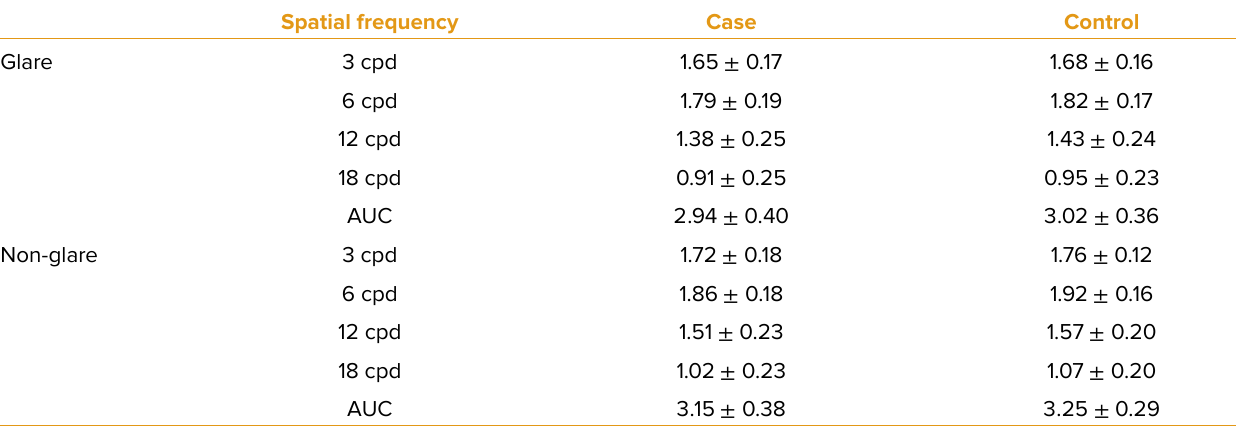
Table 1. Contrast sensitivity values in log units in the case and control groups.